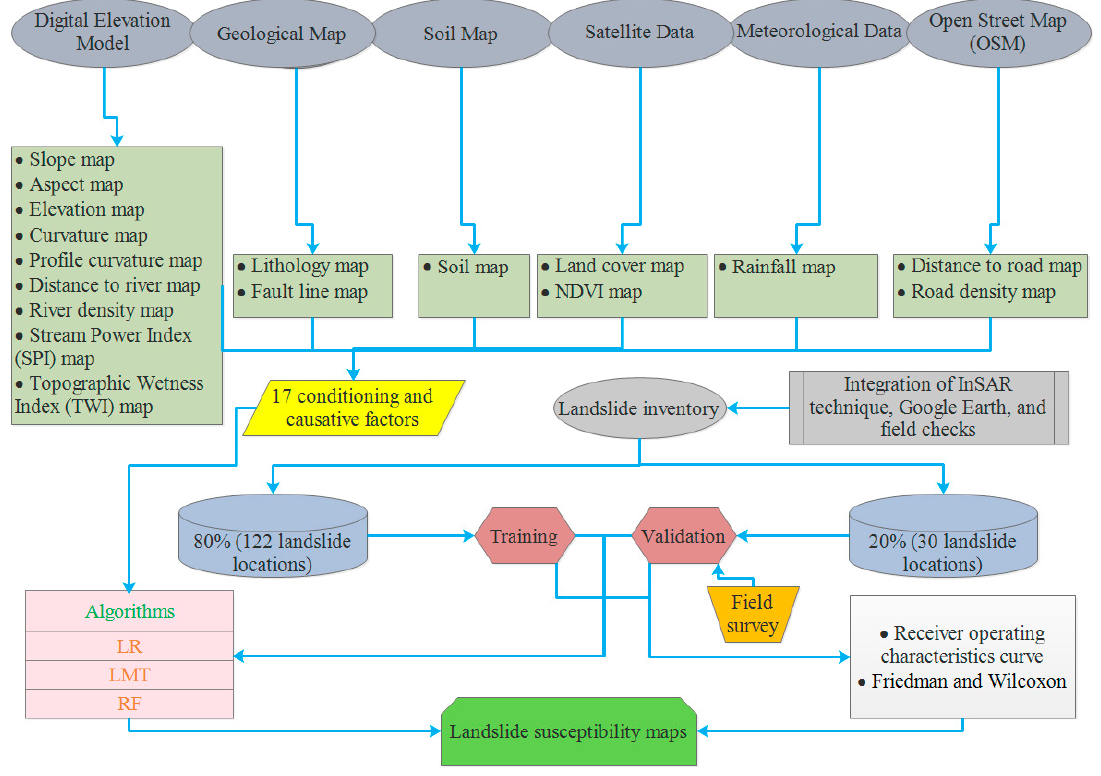
Figure 2. Workflow of the study.